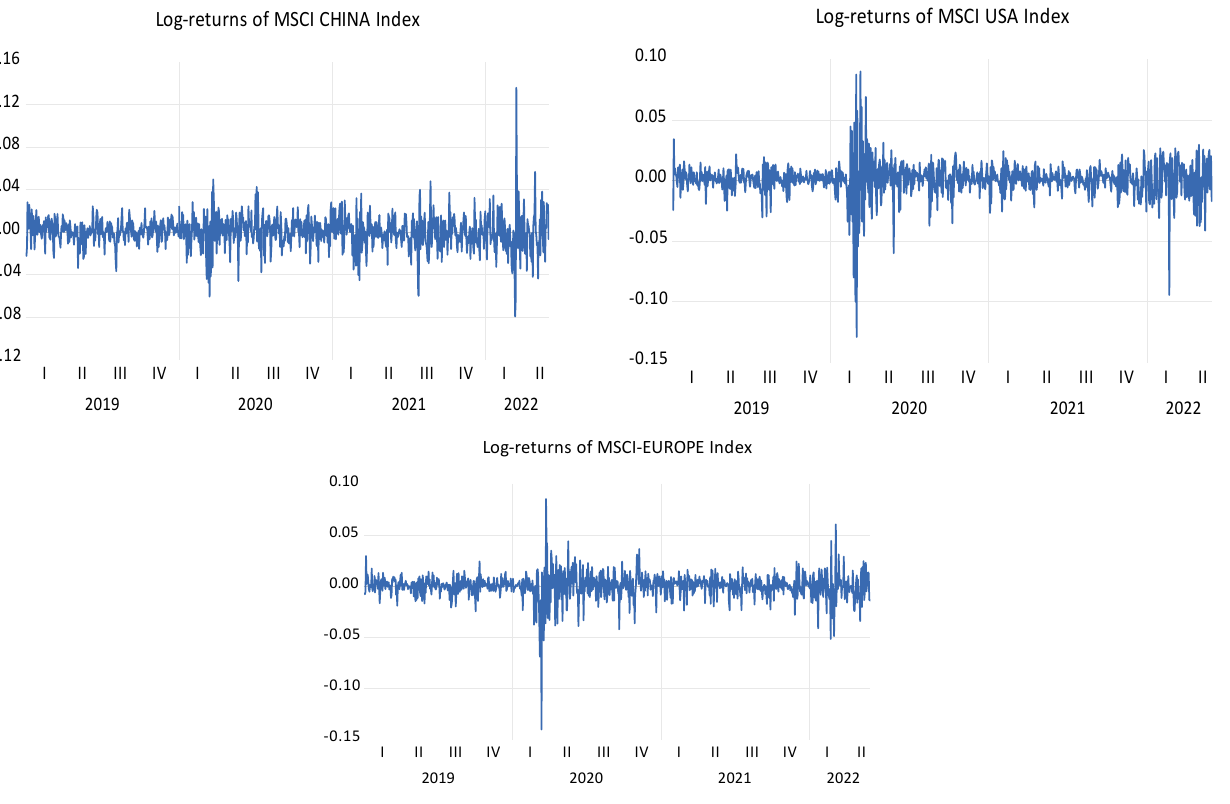
Figure 2. Daily returns of the stock market indices.